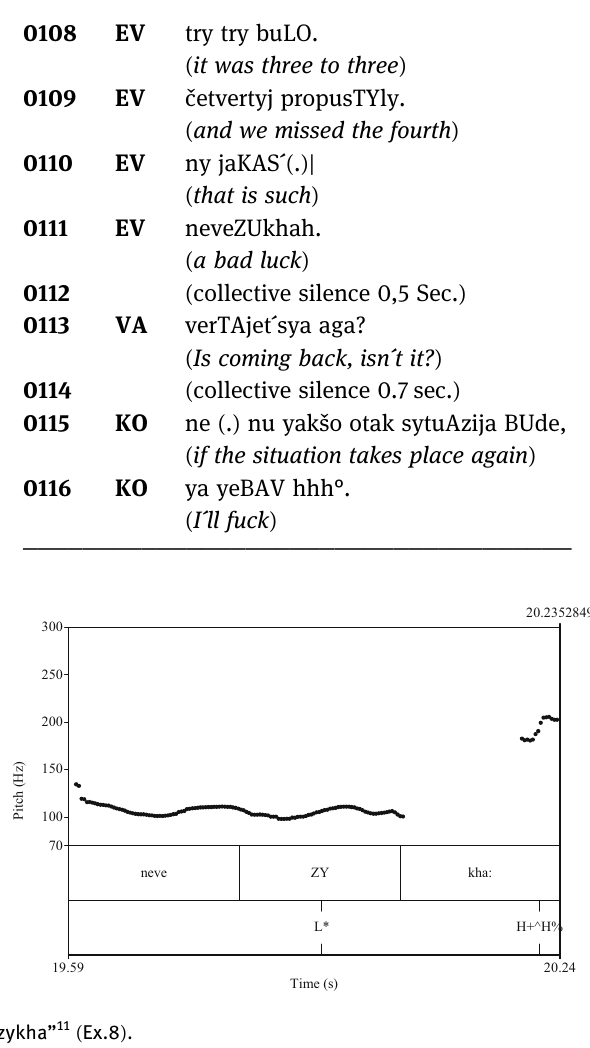
Table 3: Overview of embarrassment - displays in Ukrainian data Kind of marker Placement Items in %